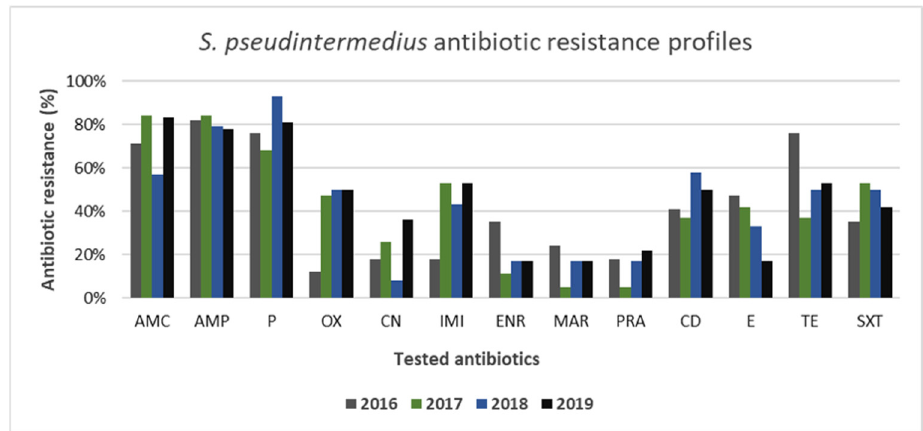
Figure 6. Antimicrobial resistance profiles of canine S. pseudintermedius strains to commonly used antibiotics.